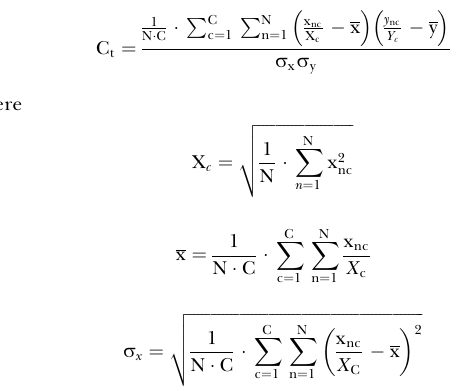
ffiffiffiffiffiffiffiffiffiffiffiffiffiffiffiffiffiffiffiffiffiffiffi 1